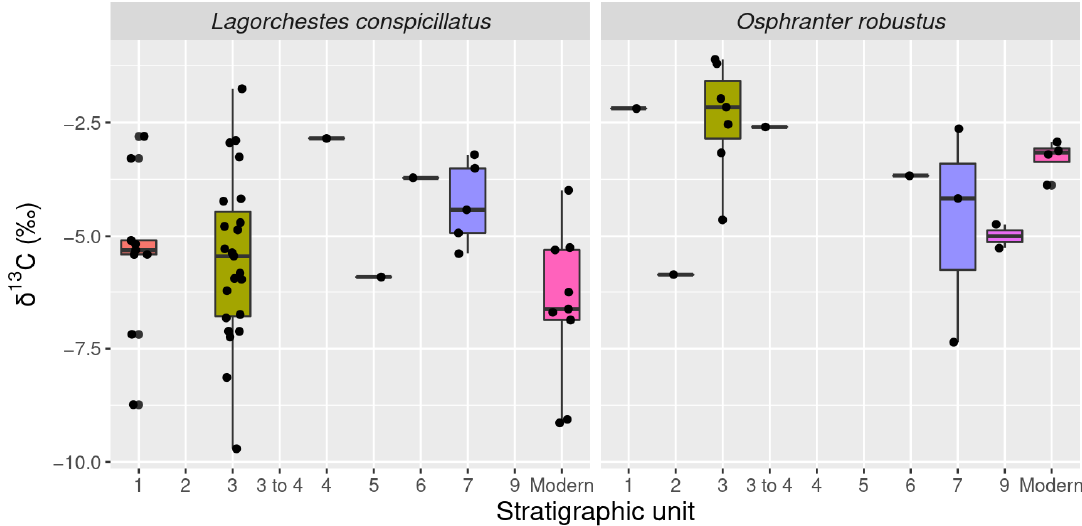
13 C by stratigraphic